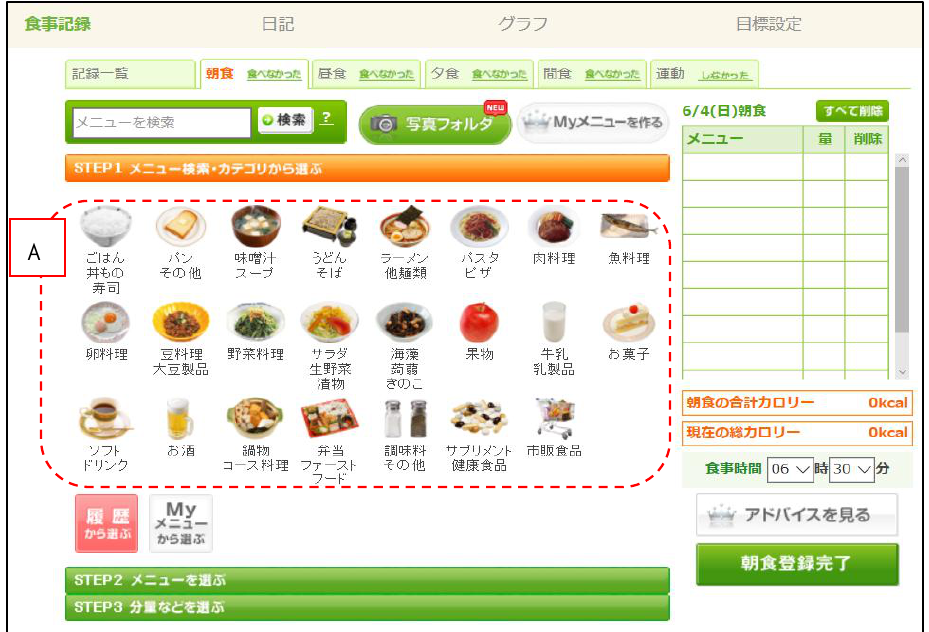
Figure 1. Creating a dish record using the Japanese version of Asken. Users select the category of their dish and then choose the specific dish. Translation of dish names in area A (left to right): Top row: rice, bread, miso soup, soba, ramen, pasta, meat dishes, and fish dishes. Middle row: egg dishes, bean dishes, vegetable dishes, salads, seaweed and mushrooms, fruits, milk, and confectioneries.